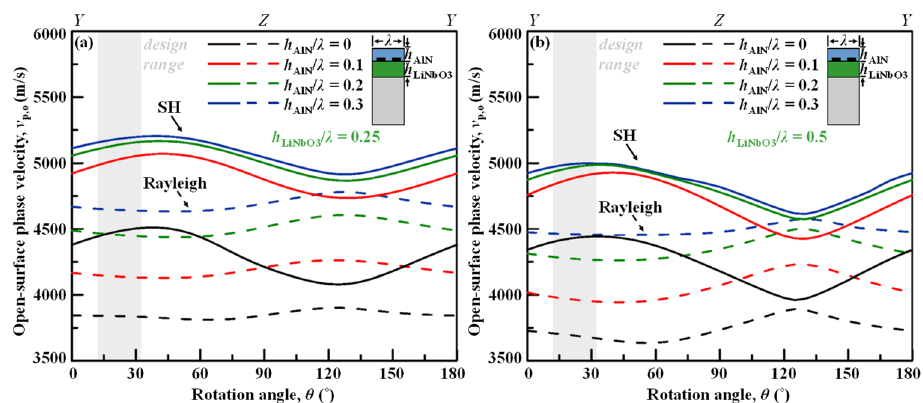
Figure 5. Calculated open phase velocities v p,o for varied thicknesses of AlN overlay layer on LiNbO 3 /Si across all rotation angles from the YX -LiNbO 3 with ( a ) h LiNbO3 / λ = 0.25, and ( b ) h LiNbO3 / λ = 0.5.